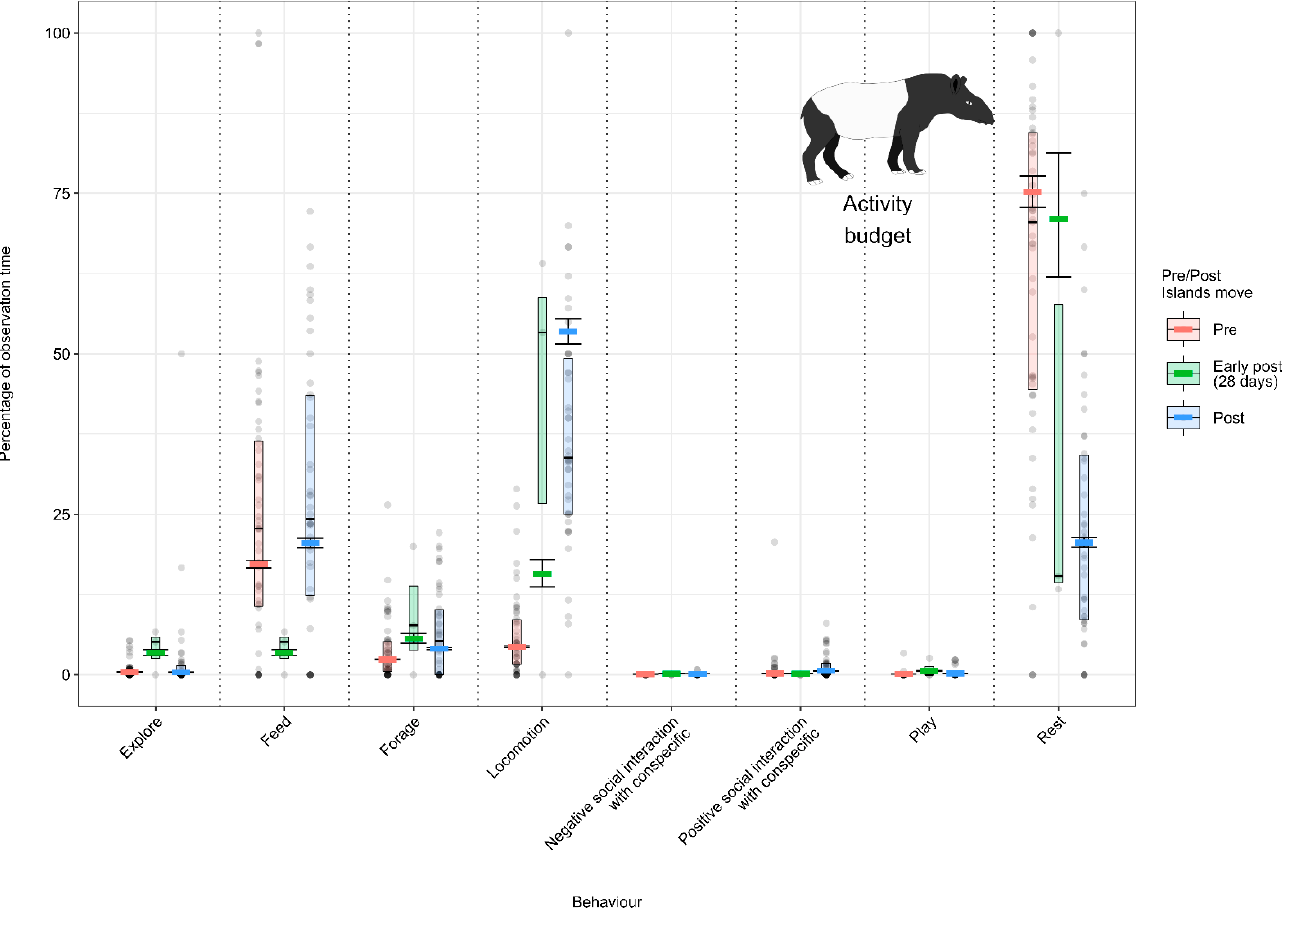
Figure 5. Proportion of time Malayan tapirs spent performing each behaviour (expressed as a per- centage of the total observation time) under the pre-, early-post- and post-enclosure-move conditions. The model’s fitted values are represented by coloured horizontal lines, and their respective 95% confidence intervals are depicted as black error bars. Coloured boxes with black horizontal lines depict the medians and quartiles of the response. Grey dots represent raw data points, shaded according to frequency (dark indicates many observations, light indicates few).